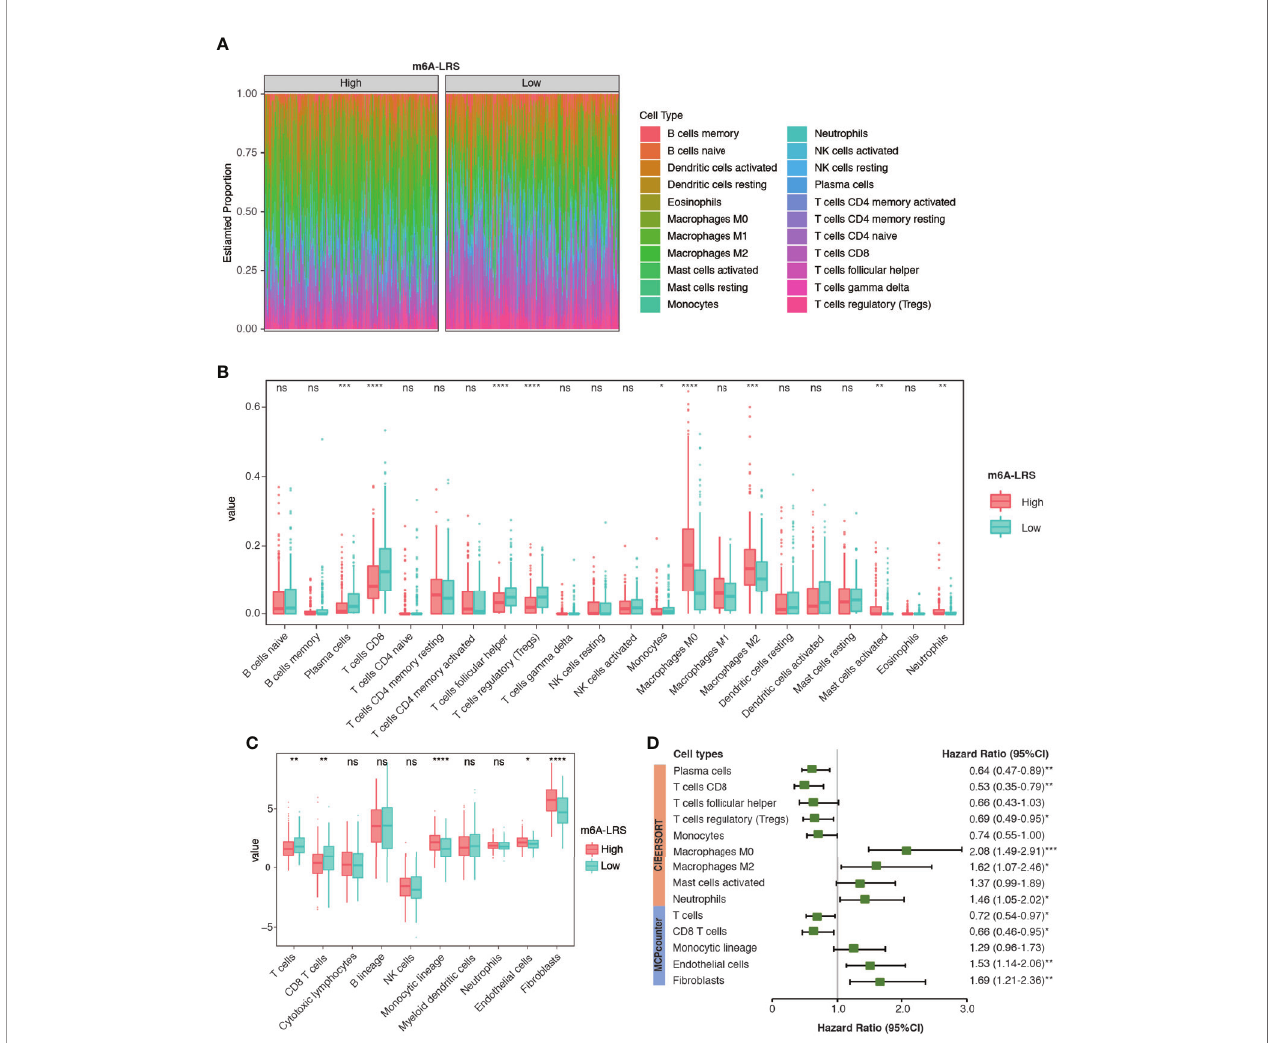
FIGURE 6 | Characteristics of TME cell in fi ltration in high- and low m6A-LRS subgroups in TCGA. (A) The TME in fi ltrating cell pro fi le in the high- and low-risk subgroups. Relative abundances of 22 cell types were calculated using the CIBERSORT algorithm. (B) Comparison of the abundances of in fi ltrating cells in high- and low-risk subgroups. The upper and lower ends of the boxes represent the interquartile range of values. The lines in the boxes represent median values, and dots show the outliers. (C) Comparison of TME stromal and immune cell abundances estimated by “ MCPcounter ” in the high- and low-risk subgroups. (D) Univariate Cox regression of the differential cell types for overall survival. The optimal cut-off value used for grouping was determined using the “ sur_cutpoint ” function. m6A-LRS: m6A-related lncRNA risk score. *P < 0.05; **P < 0.01; ***P < 0.001, ****P < 0.0001. ns, non-signi fi